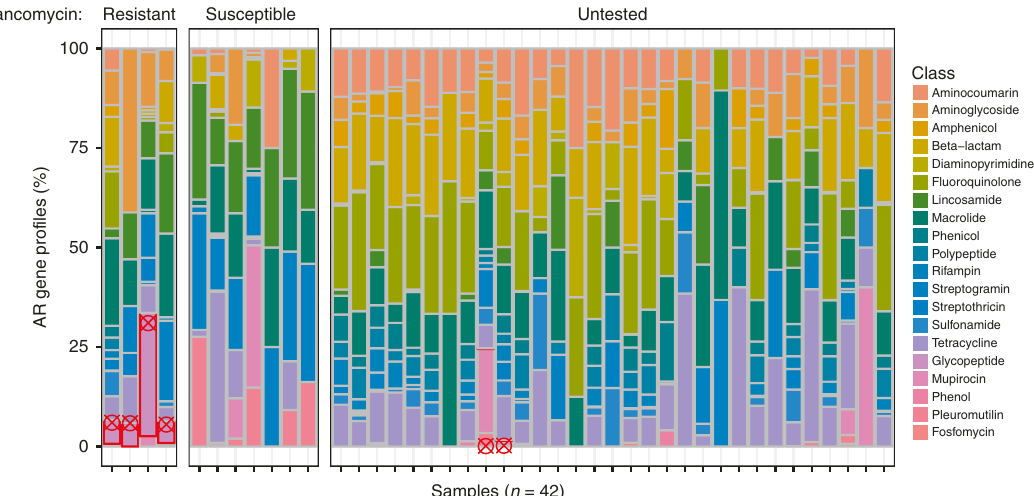
Fig. 4 cfDNA-based antimicrobial resistome pro fi ling. For 42 samples from subjects with clinically con fi rmed UTI, AR gene pro fi ling reveals the presence of genes conferring resistance to various antimicrobial classes. These data are organized in three sample groups: samples from subjects with vancomycin- resistant Enterococcus (Resistant), samples from subjects with vancomycin-susceptible Enterococcus (Susceptible), and samples from subjects for which vancomycin resistance testing was not performed (Untested). Samples in which fragments of genes that confer resistance to glycopeptide class antibiotics (including vancomycin, red outlines) were detected are marked by red crosshairs. See Supplementary Data